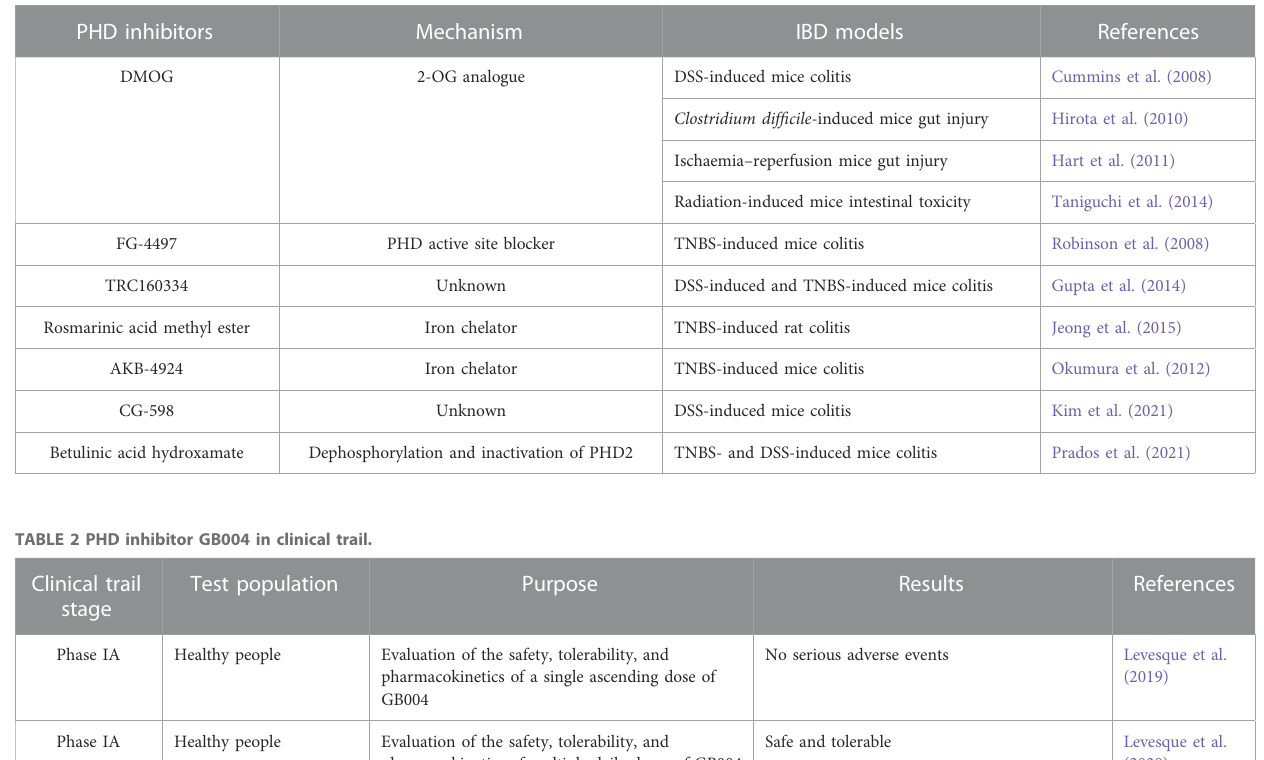
TABLE 1 PHD inhibitors in treatment of gut in fl ammation in animal models. PHD inhibitors